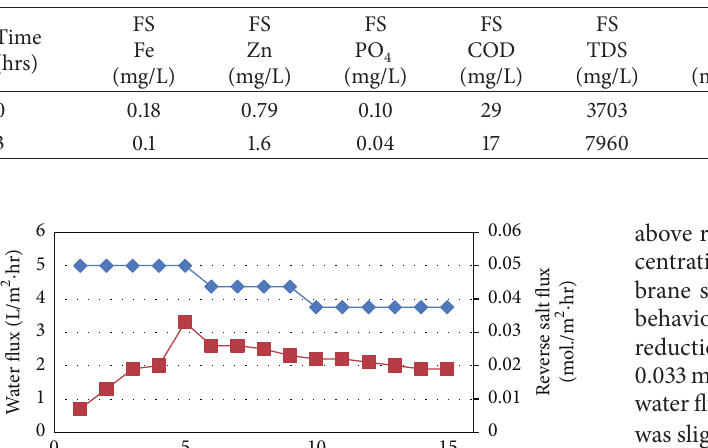
Table 3: Analysis of concentrated Ezz Steel treated wastewater from FO after 6 hrs and RO concentrate before and after 2nd stage of FO-batch process.